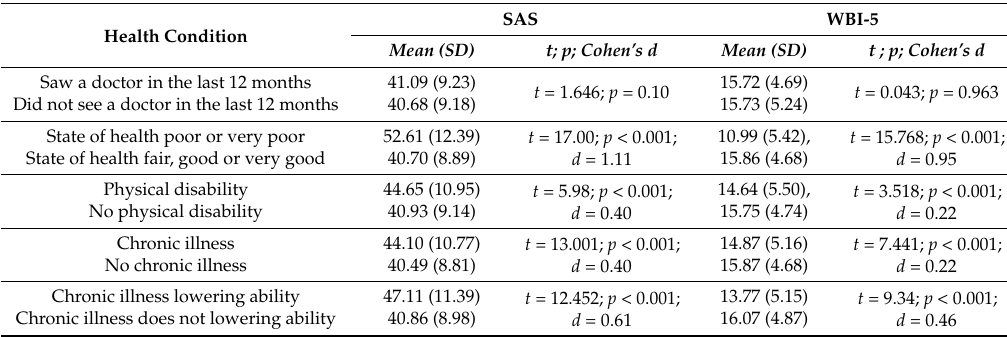
Table 3. Differences in anxiety and subjective well-being in the study groups.